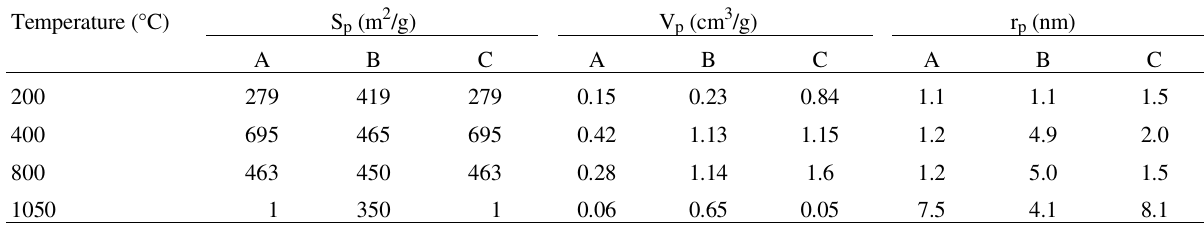
Table 1. Structural properties of silica